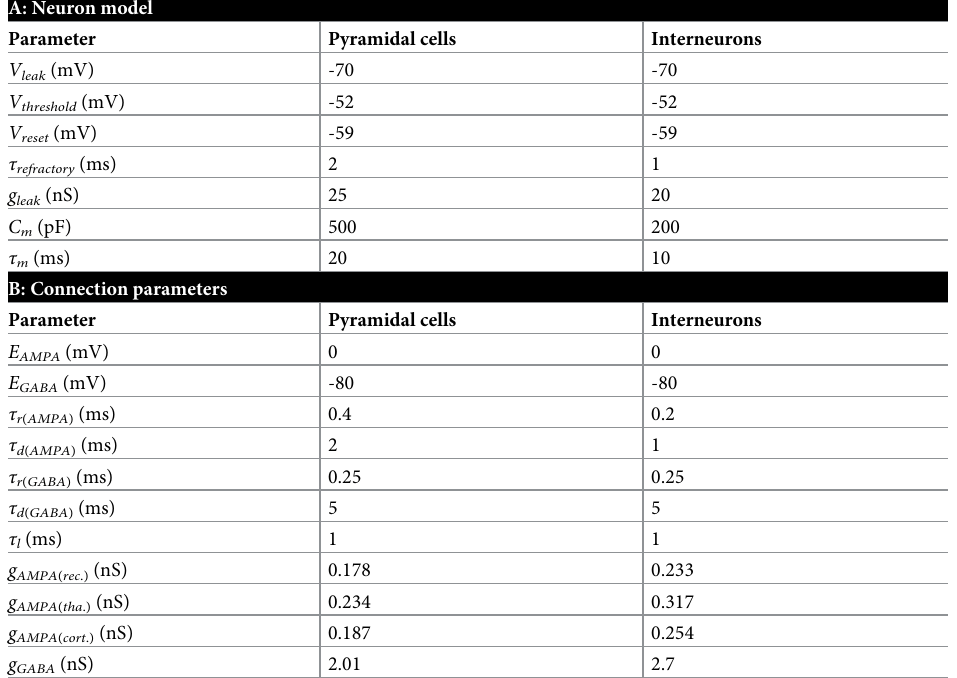
Table 4. Parameters of the neuron models used in the point-neuron network.